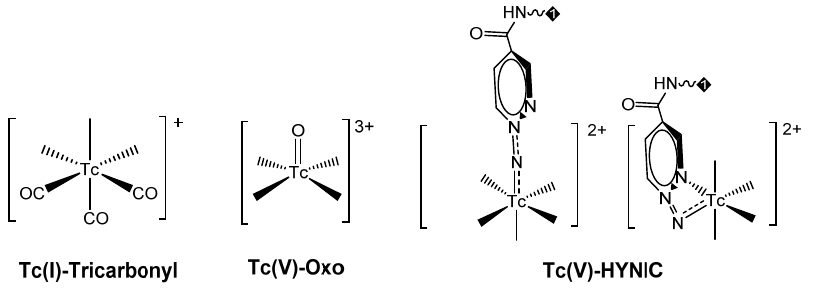
Figure 8. Chemical representation of the Tc-moieties utilized in developing [ 99m Tc]Tc-housed